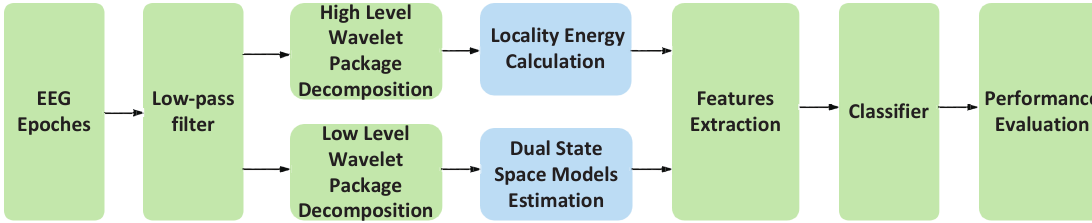
Figure 1. A schematic outline of the proposed improved model based essence features (IMBEFs) based sleep stage classification